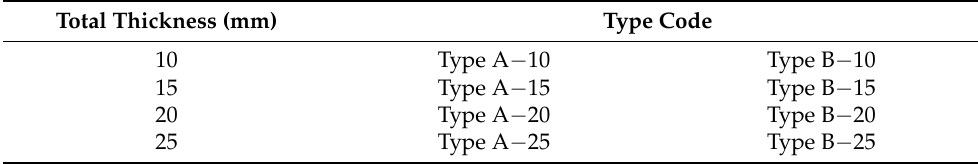
Table 3. Total thickness of PMs and the corresponding type code.